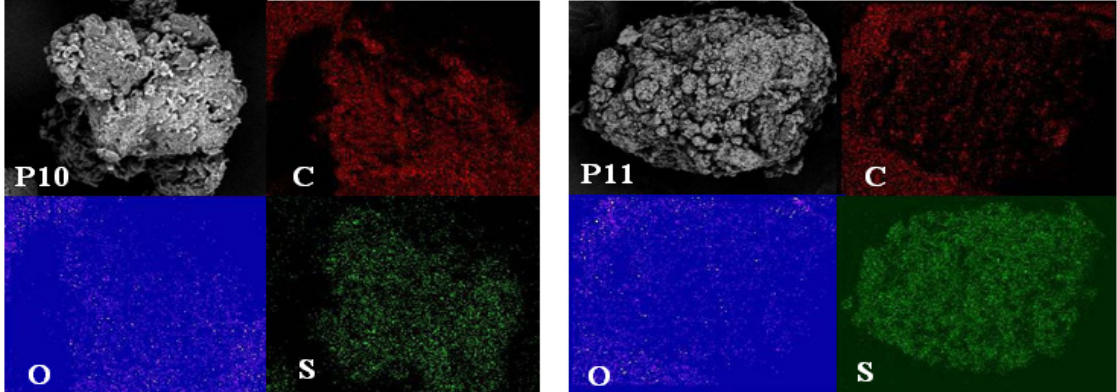
Figure 3. SEM micrographs of polymers P10, P11, P151, and P15 and elemental maps for carbon (C), oxygen (O), and sulphur (S) for the same regions obtained by EDX